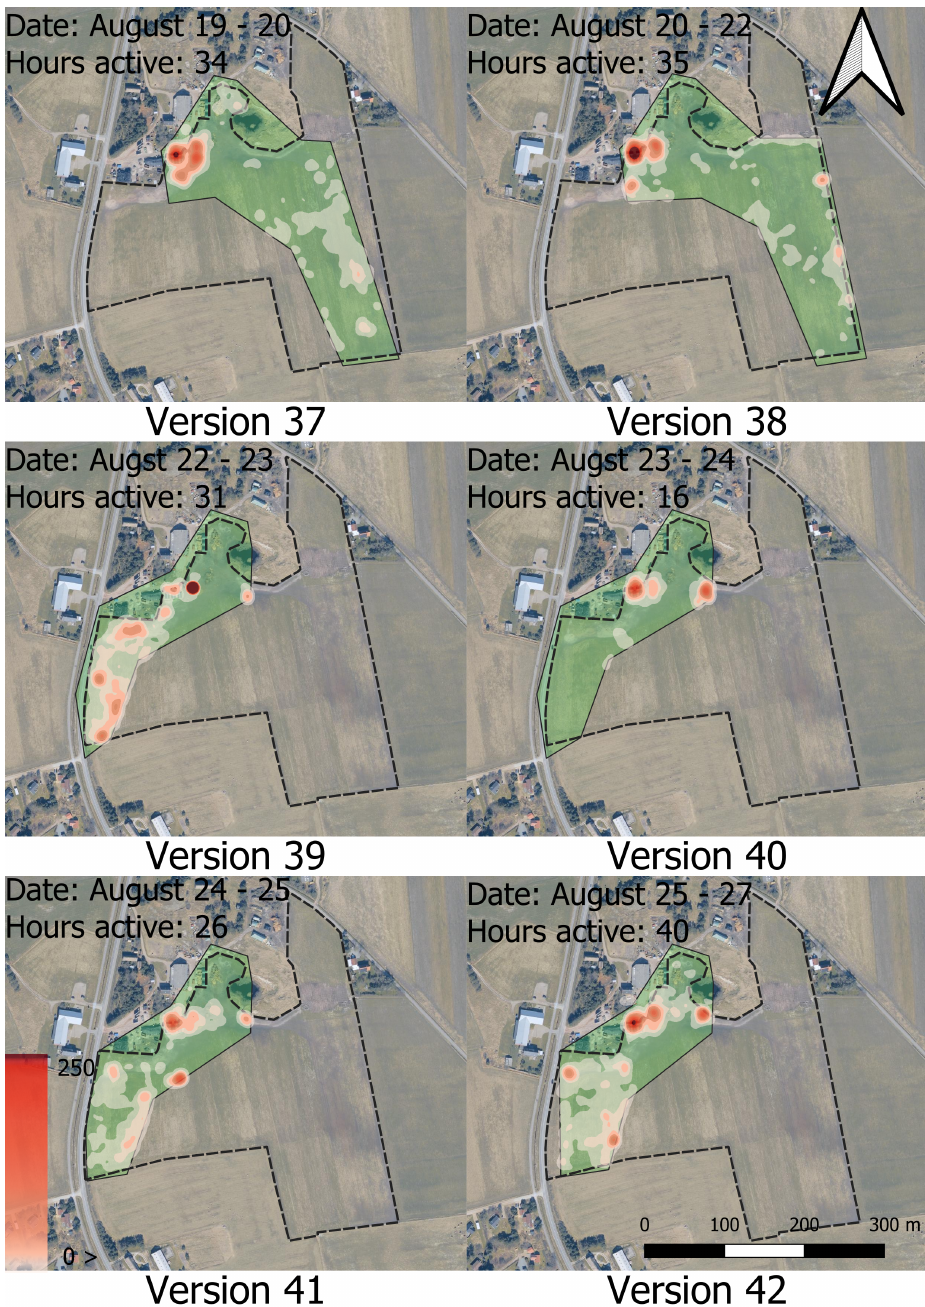
Figure A16. Heatmap series 7 visualising all Poll messages sent during the period from 19 August to 27 August. The green area shows the virtual enclosure area to which the bull calves were limited. The white to red colour indicates the number of Poll messages within a 10 m radius. The brightest colour represents the areas with the lowest density of Poll messages, while the darkest colour represents the areas with 250 or more Poll messages within the radius. The coordinates of the upper left corner of the map frame are 55°25 (cid:48) 23.131 (cid:48)(cid:48) E 8°23 (cid:48) 53.531 (cid:48)(cid:48) N. Contains data from the Agency for Data Supply and Infrastructure, Forårsbilleder Ortofoto-GeoDanmark, December